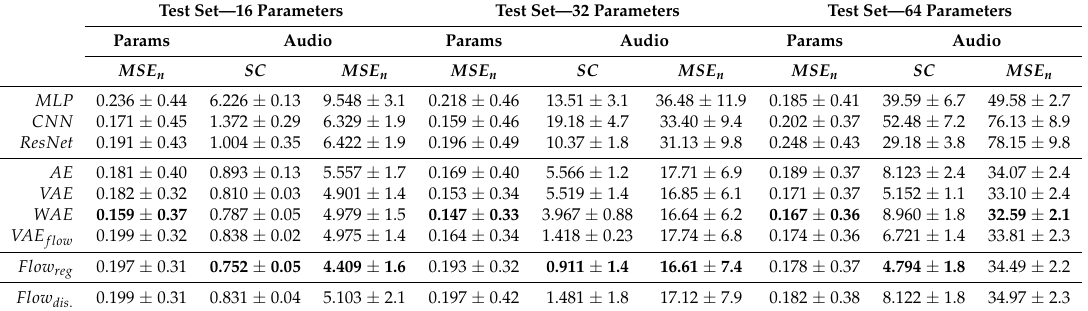
Table 1. Comparison between baselines, *AEs, and our flows on the test set with 16, 32, and 64 parameters. We report across-folds mean and variance for parameters (Mean-Squared Error [ MSE n ]) and audio (Spectral Convergence [ SC ] and MSE n ) errors. The best results are indicated in